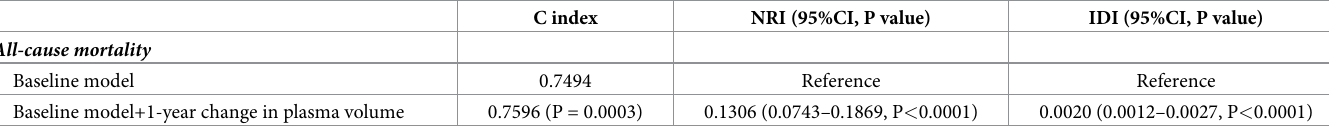
Table 6. Statistics for model fit and improvement with the addition of 1-year change in plasma volume on the prediction of all-cause